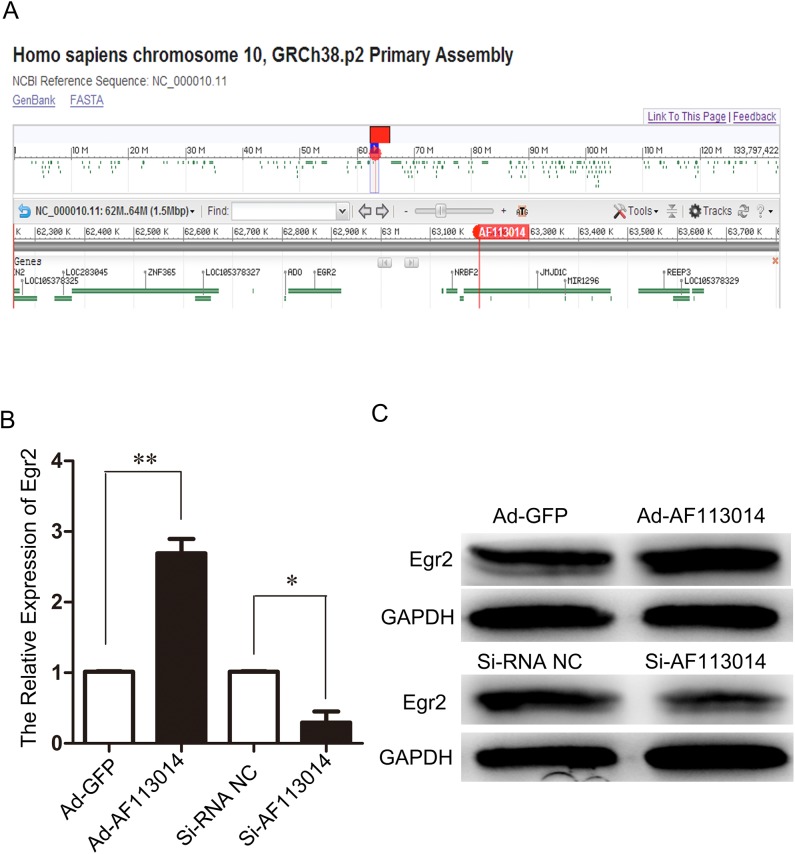
Egr2 was downstream target gene of AF113014.(A) The location of AF113014 in chromosome 10. (B, C) Relative mRNA and protein expressions of Egr2 in Ad-AF113014 or siAF113014 transfected SMMC7721 cells, respectively. GAPDH was used as an internal quantitative control. * P < 0.05, ** P<0.01.